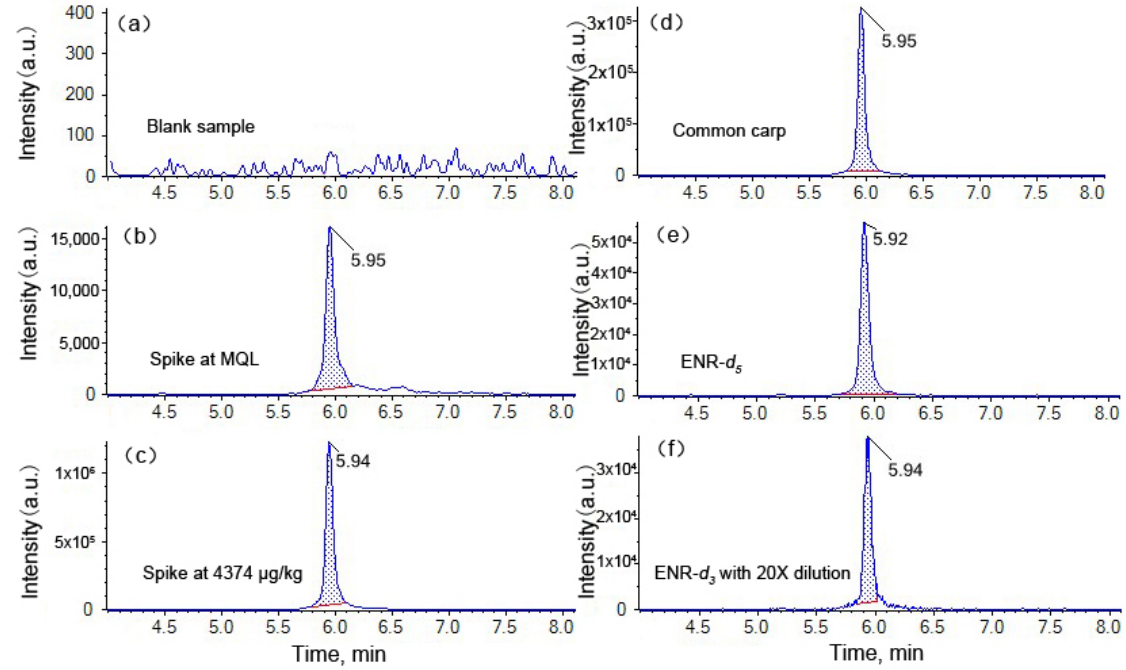
Figure 5. HPLC − MS/MS chromatograms: ( a ) blank sample (EIC of ENR); ( b ) blank samples spiked with ENR at an MQL of 2 µg/kg (EIC of ENR); ( c ) blank samples spiked with ENR at 4374 µg/kg (EIC of ENR); ( d ) positive sample, common carp (EIC of ENR); ( e ) EIC of ENR- d 5 ; ( f ) EIC of ENR- d 3 (samples in ( c ) and ( f ) were diluted at a ratio of 1:20). Table 2. Recovery and RSDs of a spiking experiment in a positive sample with the dual isotope surrogates method for the determination of ENR (n = 3).